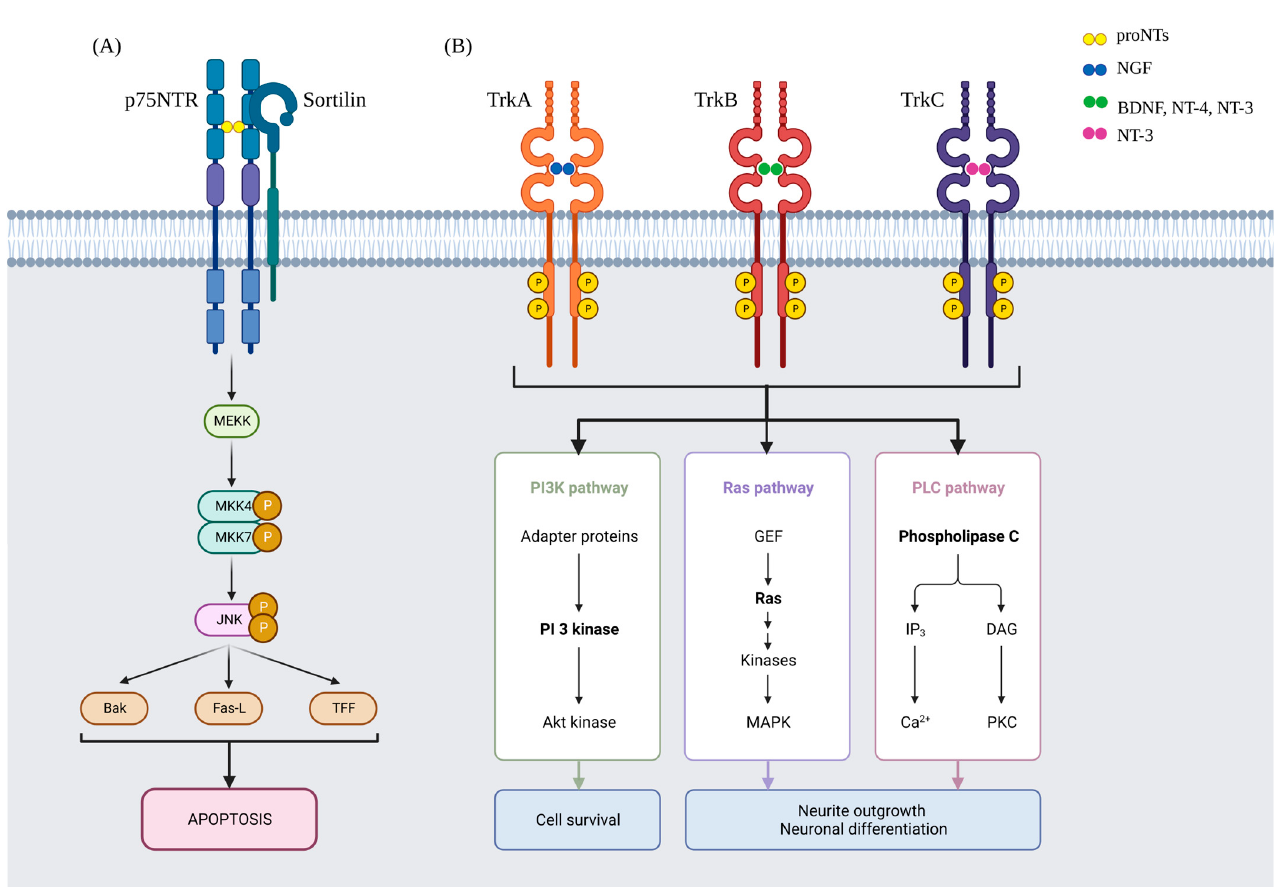
Figure 1. Neurotrophins pathways. ( a ) proNTs, including proBDNF and proNGF (proNT ‐ 3, proNT ‐ 4 in a lesser extent), have pro ‐ apoptotic activity. They make a complex with sortilin and p75NTR, initiating the JNK pathway. ( b ) Trk family are receptor tyrosine kinases family which shows affinity to NTs. They act through many pathways, such as PI3K/AKT, Ras/MAPK, and PLC/PKC. Akt—serine/threonine protein kinase; Bak—BCL ‐ 2 homologous antagonist/killer; BDNF—brain ‐ derived neurotrophic factor; DAG—diacyloglycerol; Fas ‐ L—tumor necrosis factor ligand superfamily member 6; IP3—inositol trisphosphate; JNK—c ‐ Jun N ‐ terminal kinase; MAPK—mitogen ‐ activated protein kinase; MEKK—mitogen ‐ activated protein kinase kinase kinase 1; MKK4—mitogen ‐ activated protein kinase kinase 4; MKK7—mitogen ‐ activated protein kinase kinase 7; NGF—nerve growth factor; NT ‐ 3—neurotrophin 3; NT ‐ 4—neurotrophin 4; p75NTR—p75 neurotrophic receptor; PI3K—PI3 ‐ kinase type 3; PKC—protein kinase C; proNTs—premature neurotrophins; Ras—KRAS proto ‐ oncogen; TFF—trefoil factor 1; TrkA/B/C—tropomyosin receptor kinase A/B/C.